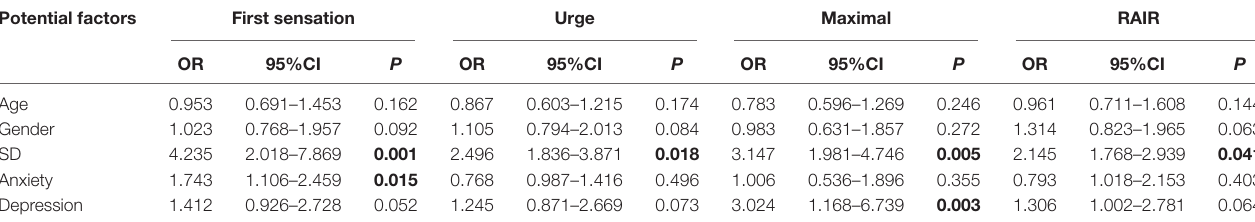
TABLE 4 | Multivariate logistic regression analysis about the potential factors of anorectal function for FC patients. Potential factors